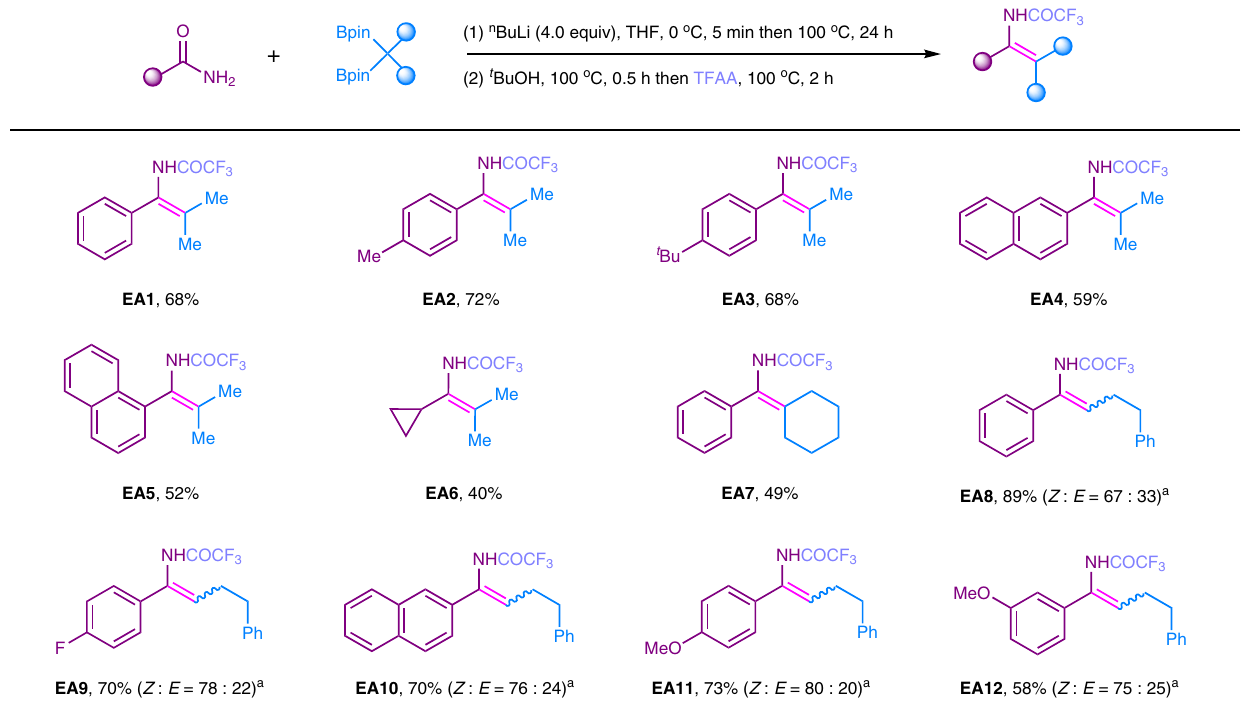
Fig. 5 Synthesis of enamides via transformation of primary amides using 1,1-diborylalkanes. Reaction conditions: 1) 1 (0.50 mmol), primiary amide (0.25 mmol), n BuLi (1.0 mmol), THF (2.0 mL), 0 °C, 5 min then 100 °C for 24 h. 2) t BuOH (0.50 mL), 100 °C, 0.5 h then TFAA (1.0 mL), 100 °C, 2 h. Yields based on isolated products. The geometry and ratios of Z/E were determined by NMR analysis and shown in parenthesis. a 12 h. TFAA: tri fl uoroacetic anhydride.